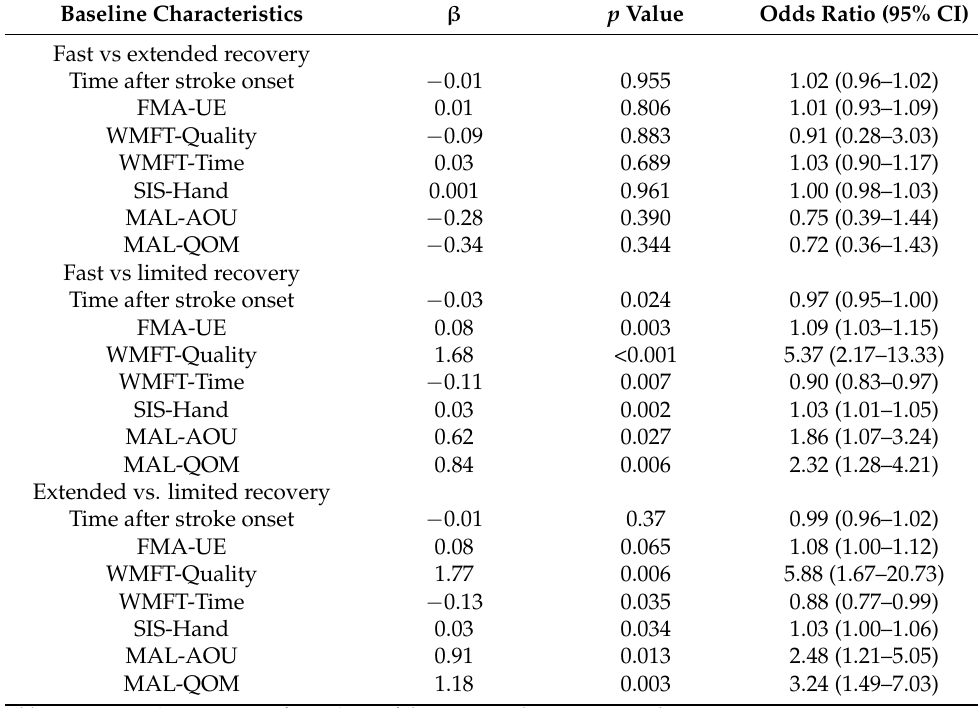
Table 3. Results of logistic regression